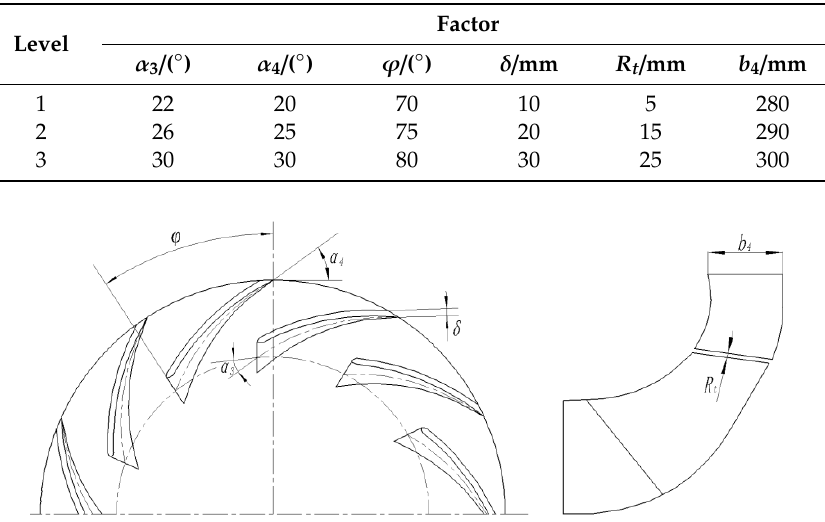
Figure 1. Main structural parameters of the guide vane.